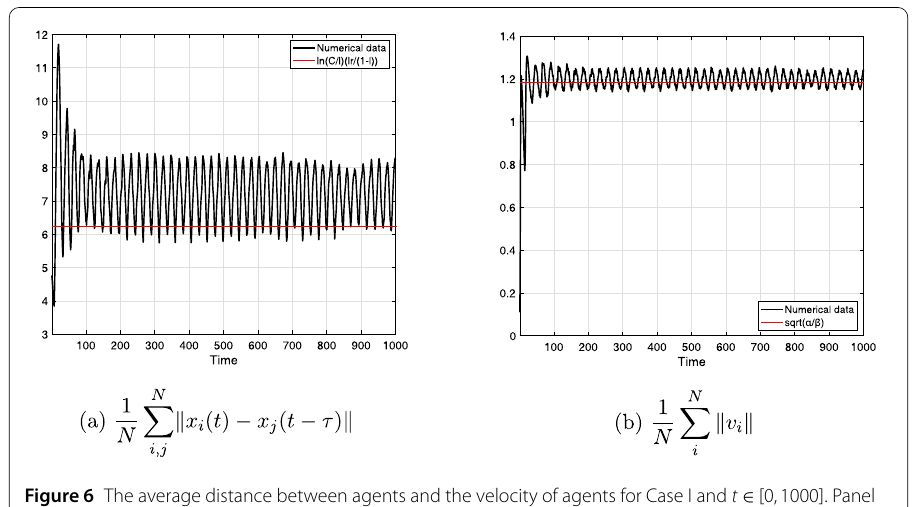
ln( C ). Panel ( b ) shows (cid:16) 1– l l α β